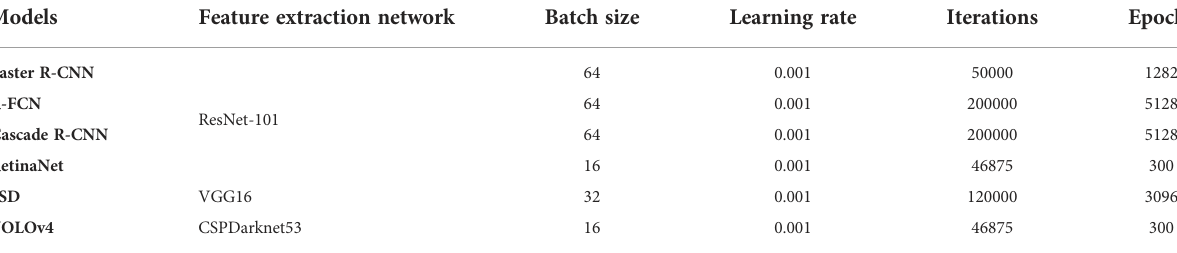
TABLE 2 Model hyper-parameters